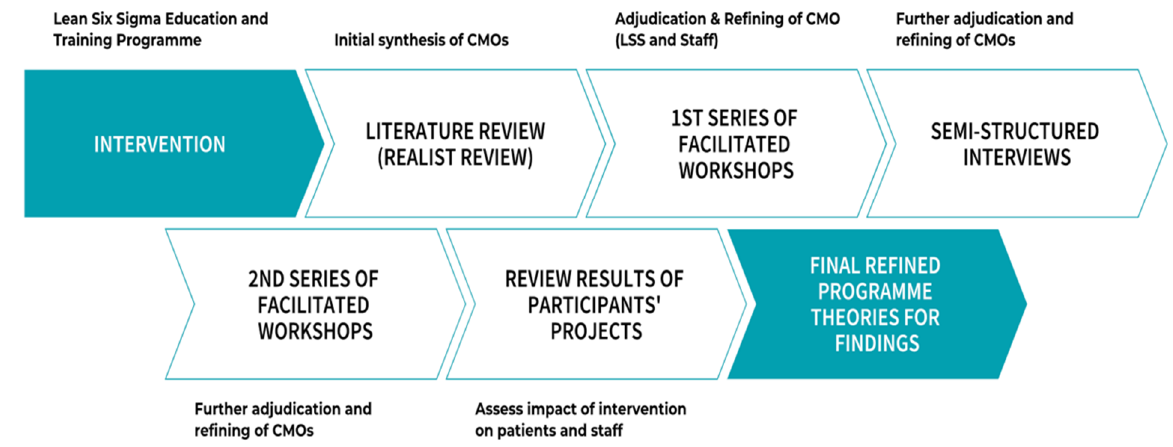
Figure 1. Methodological process.